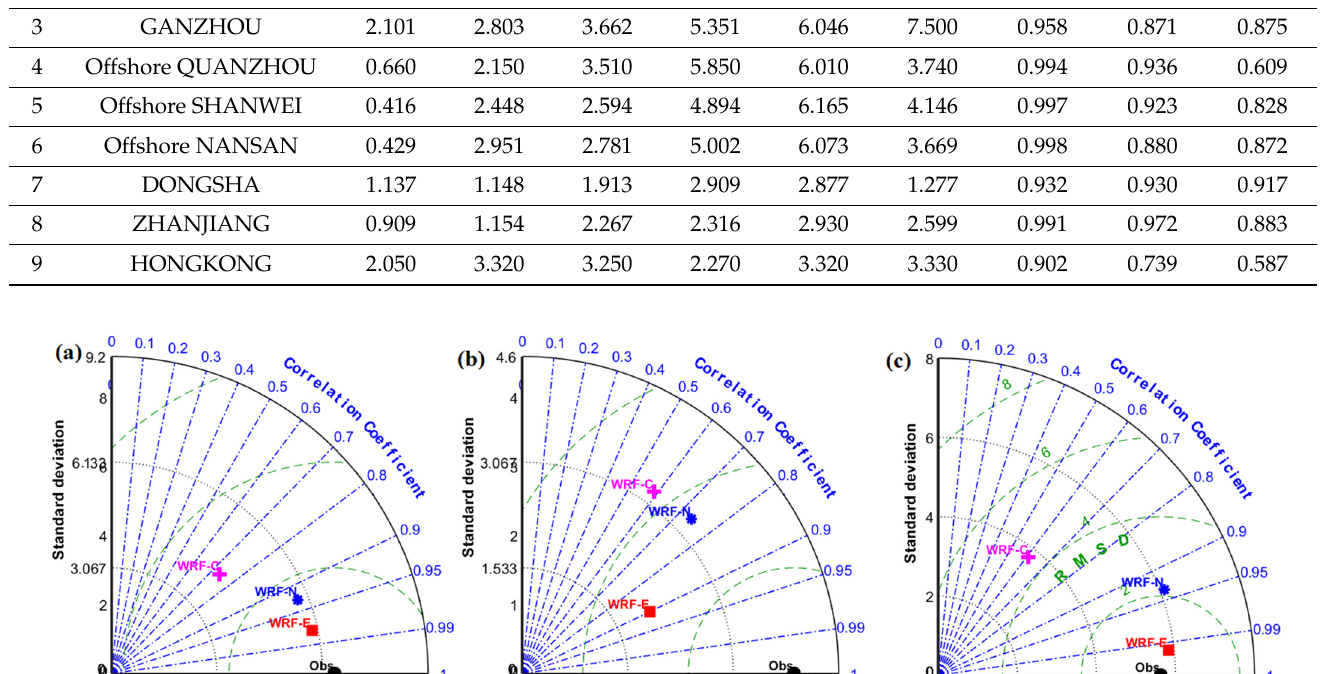
Table 3. Statistics of temperature at different locations. Figure 8. Daily average temperature in (unit: K) from the models and observations at the locations ( a ) Nanping, ( b ) Hong Kong, and ( c ) offshore Quanzhou. The RMSE and correlation for the daily average surface temperature for the entire simulation period at different locations are listed in Table 3 and three locations (Nanping, Hong Kong, and offshore Quanzhou) are compared in Figure 9 using Taylor diagrams (additional locations are available in Appendix A Figure A13). WRF-E simulations have higher correlations and smaller standard deviations. It is again noted that the models per- form well in interior and offshore China but have lower accuracy in the coastal region.